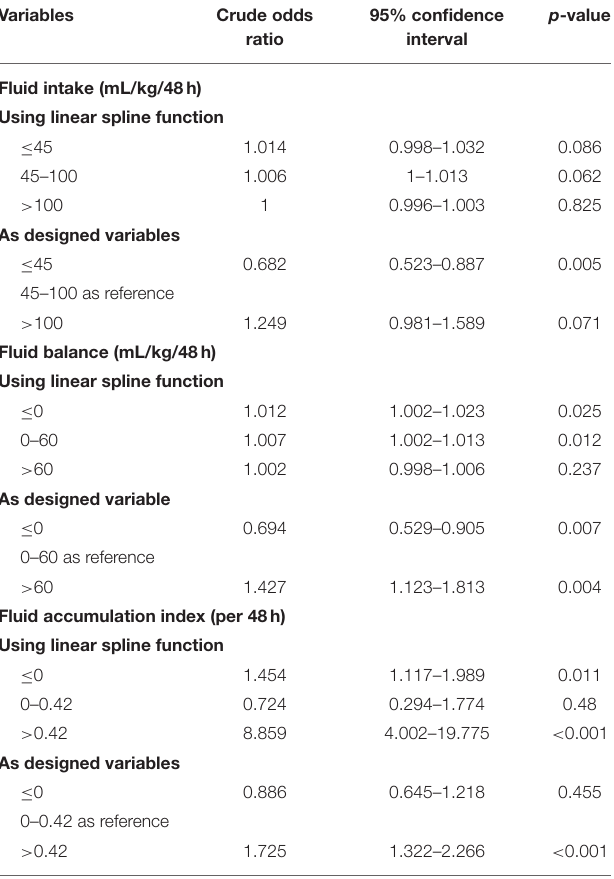
TABLE 2 | Univariable logistic regression analysis for in-hospital mortality using linear spline function and the designed variables.